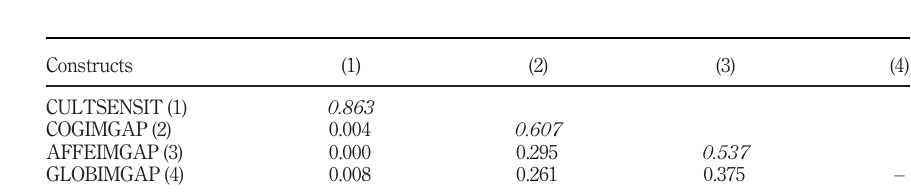
Table V. Discriminant